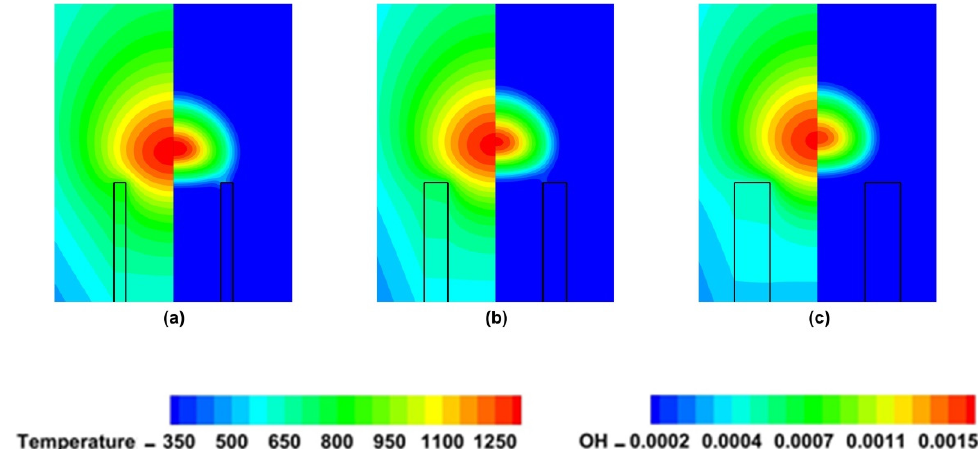
Figure 14. Static temperature ( left hand side ) and OH mass fraction contours ( right side ) near extinction for quartz burner, with radiation effects and v = 0.13 m/s ( a ) t = 0.1 mm, ( b ) t = 0.2 mm, and ( c ) t = 0.3 mm.